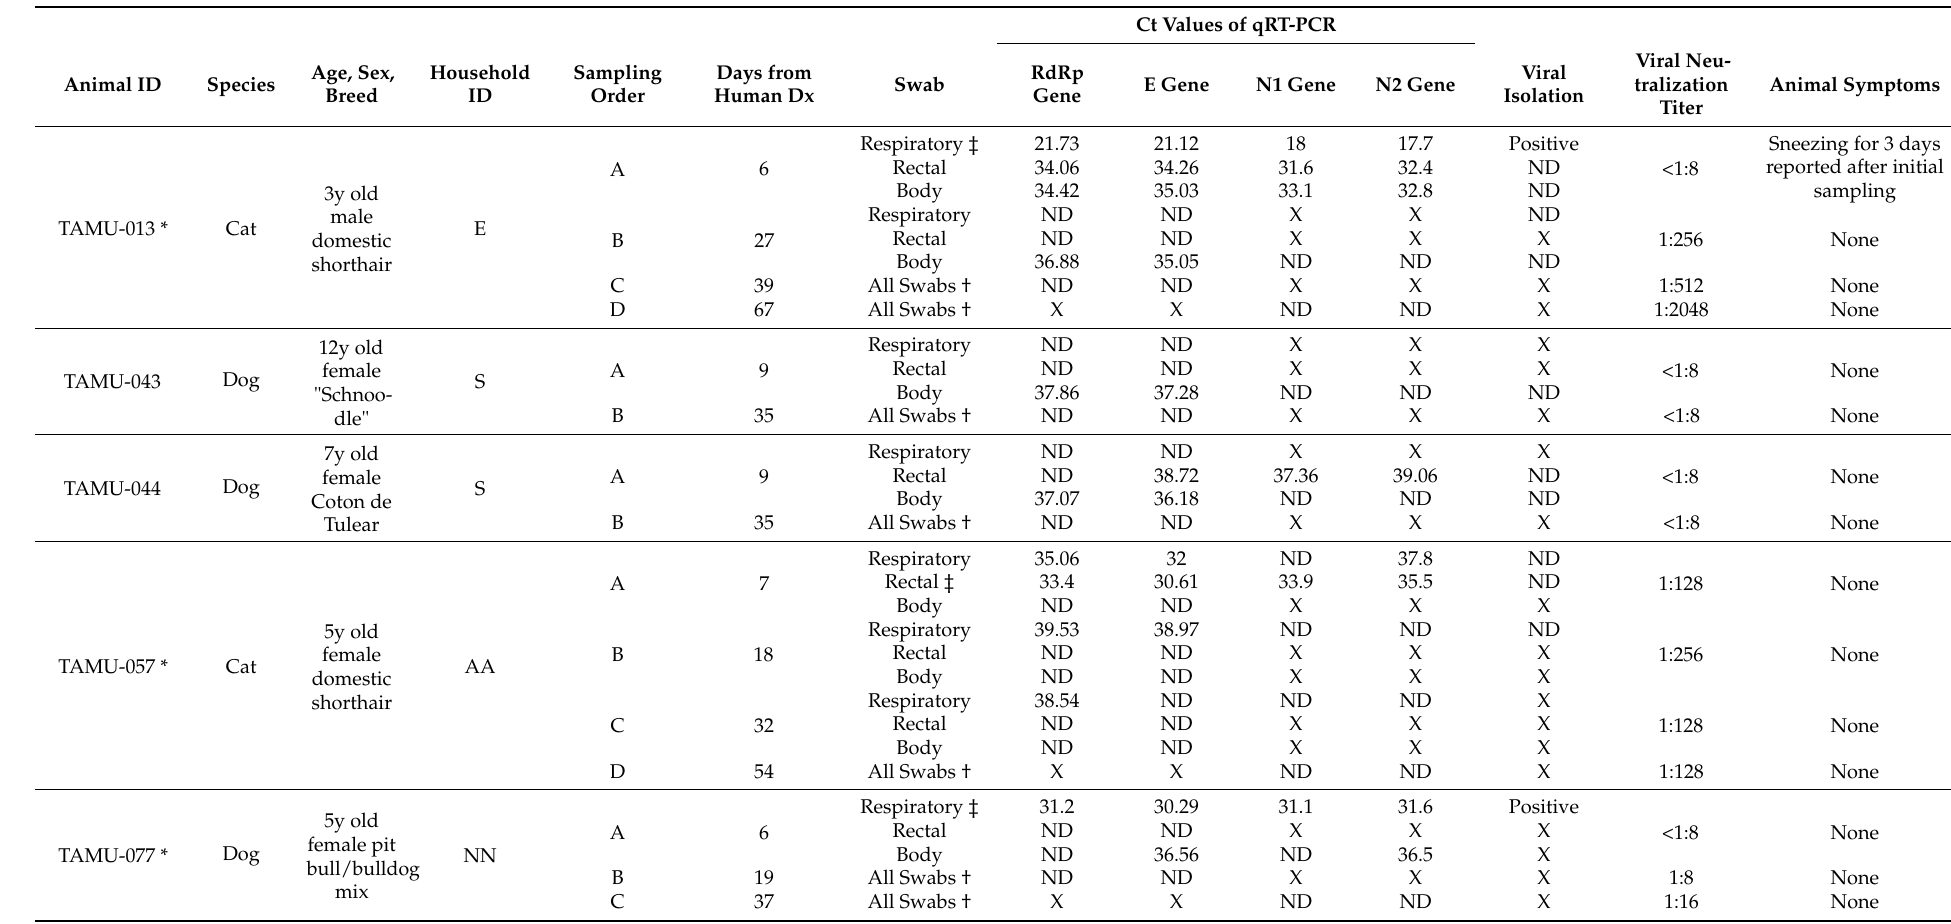
Table 1. Pets with positive screening or confirmatory qRT-PCR results for detection of SARS-CoV-2 virus from households with at least one confirmed case of human COVID-19 in Brazos County, Texas, at first (A) and subsequent (B–D) specimen collection visits from June-September 2020.